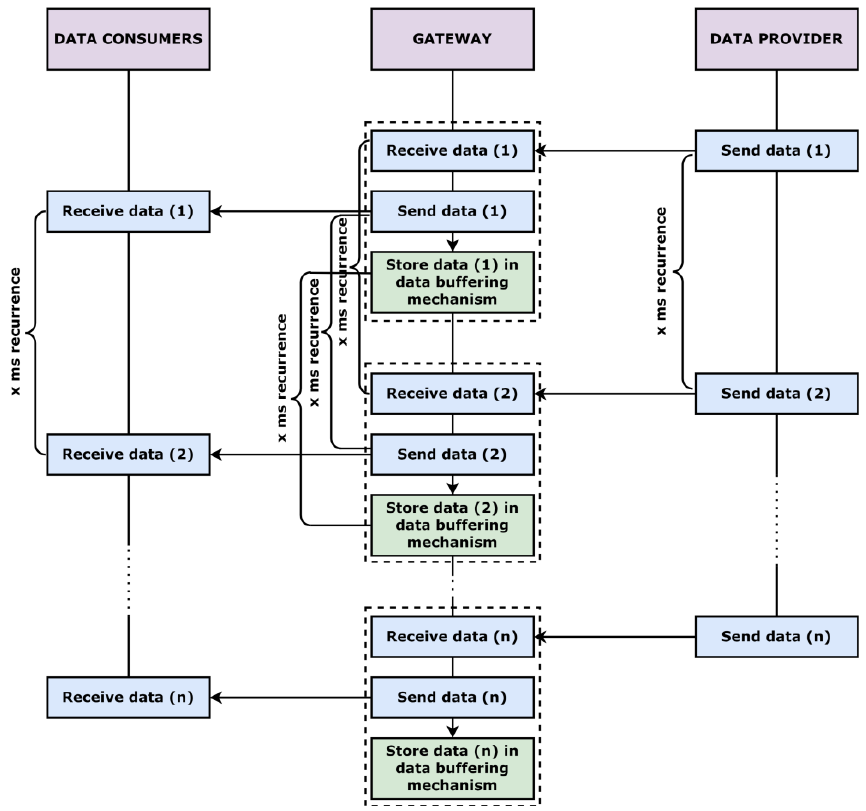
Figure 6. Data buffering sequence.